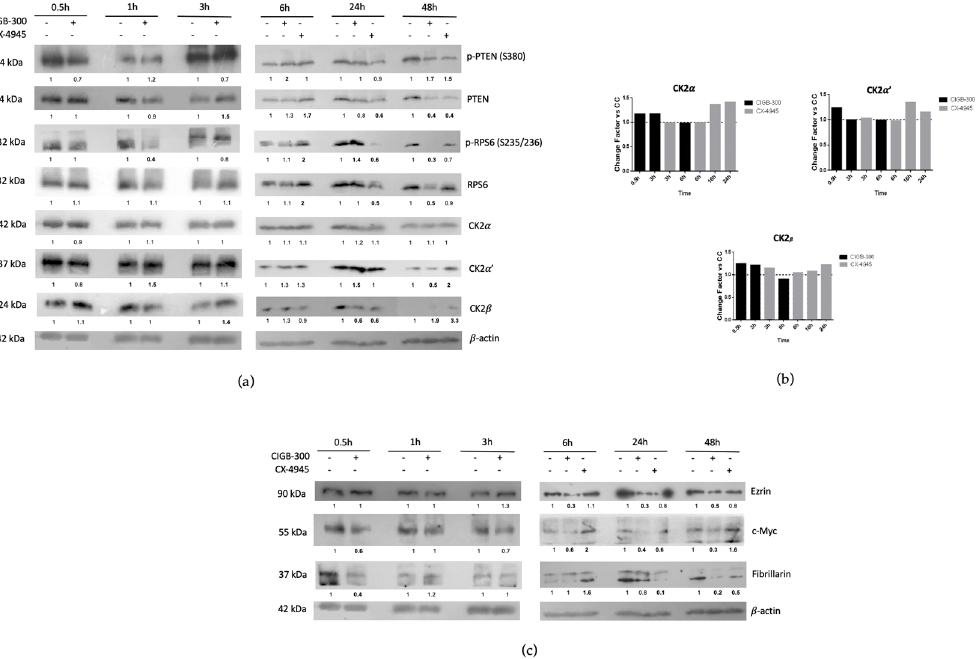
Figure 7. Time-course analysis of treatment with CIGB-300 and CX-4945 in NCI-H460: ( a ) Regulation of CK2 subunits and CK2 substrate/non-substrate proteins by Western blot; ( b ) mRNA levels of CK2 subunits; ( c ) Regulation of some cancer molecular markers after CK2 inhibition by Western blot. Expression levels were relativized with β -actin protein and appropriated housekeeping genes, respectively. Each treatment was also compared with its untreated condition.